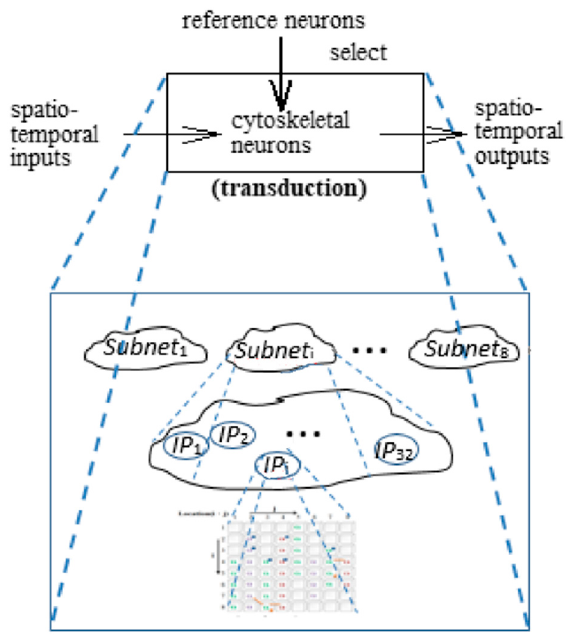
Figure 1. Architecture of the artificial neuromolecular (ANM)